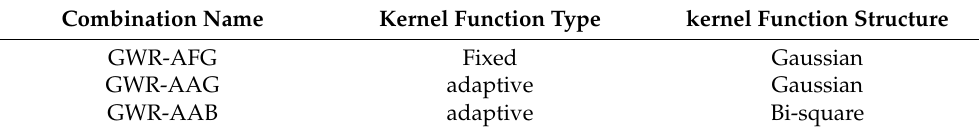
Table 4. Specific Kernel Function Combination Settings for GWR Models.